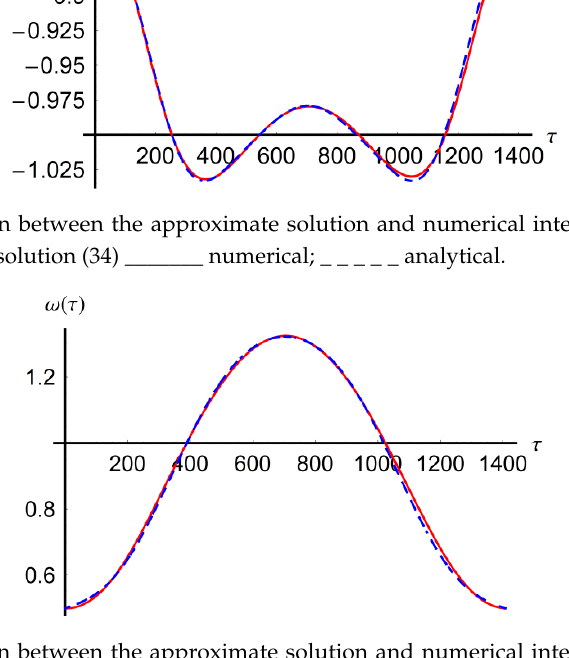
Figure 3. Comparison between the approximate solution and numerical integration results for ω :